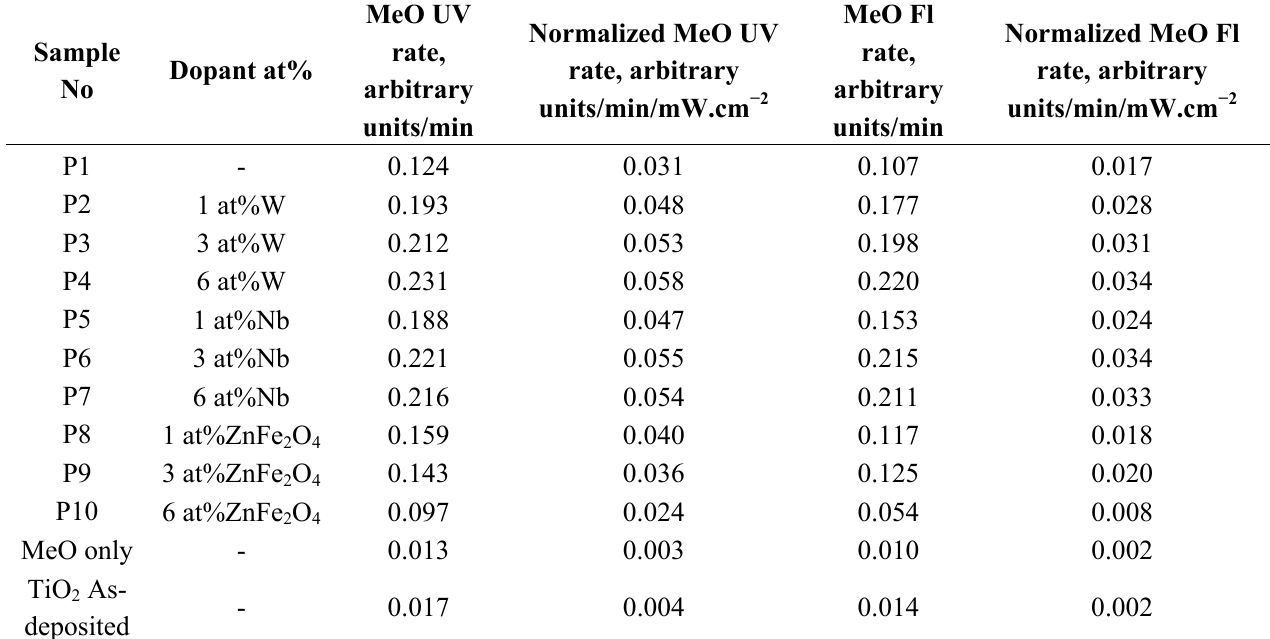
Table 2. Modulus values of degradation rates of 464 nm methyl orange (MeO) absorption peak following exposure to 352 nm UV lamps and fluorescent (Fl)